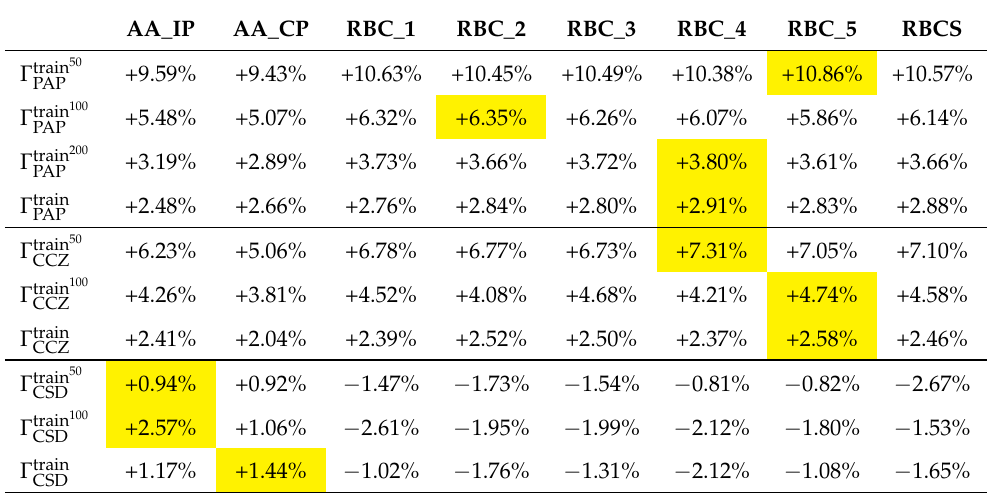
Table 11. Performance of policies applied on Γ PAP and Γ CCZ . The best performing policy is high- lighted in